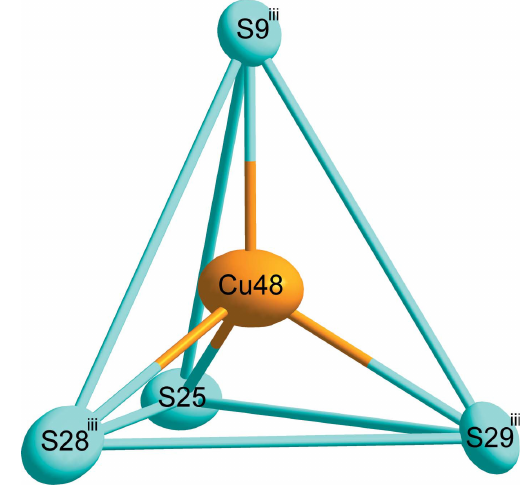
Figure 2 The environment of Cu1. Displacement ellipsoids are drawn at the 90% probability level. [Symmetry code: (i) x , y , z (cid:4) 1.]